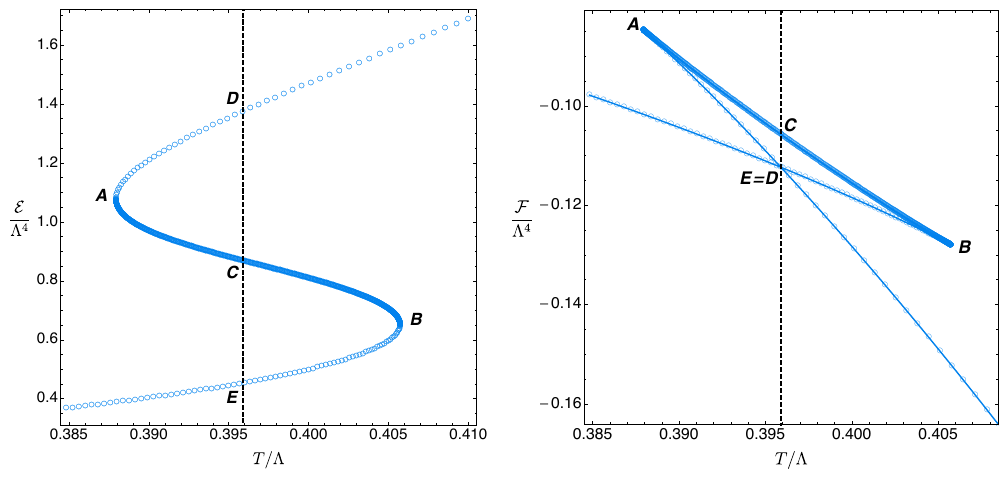
Figure 3 . Dimensionless energy density (left) and free energy density (right) as a func- tion of the dimensionless temperature for uniform nonconformal branes in our model. The curve between A and B is the spinodal region and we will refer to it as the “intermedi- ate branch”. At ˆ T c ’ 0 . 3958945 (vertical dashed line) there is a first order phase tran- sition in the canonical ensemble (see right panel). For reference here and in future plots, ( ˆ T, ˆ E ) A ’ (0 . 387944 , 1 . 076417) , ( ˆ T, ˆ E ) B ’ (0 . 405724 , 0 . 650227) , ( ˆ T, ˆ E ) C ’ (0 . 3958945 , 0 . 867956) , ( ˆ T, ˆ E ) D ’ (0 . 3958945 , 1 . 37386) and ( ˆ T, ˆ E ) E ’ (0 . 3958945 , 0 . 452754) .